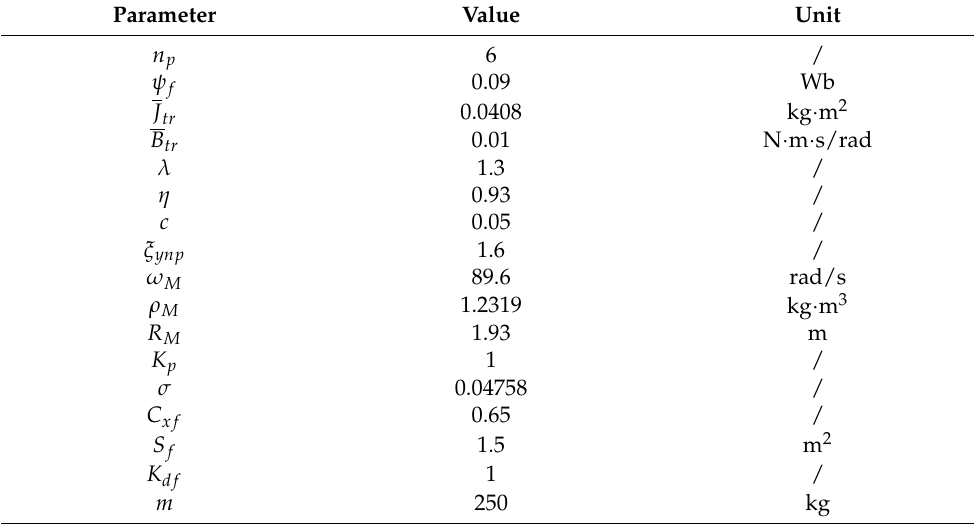
Table 1. Parameters of the unmanned helicopter and the electric tail reduction